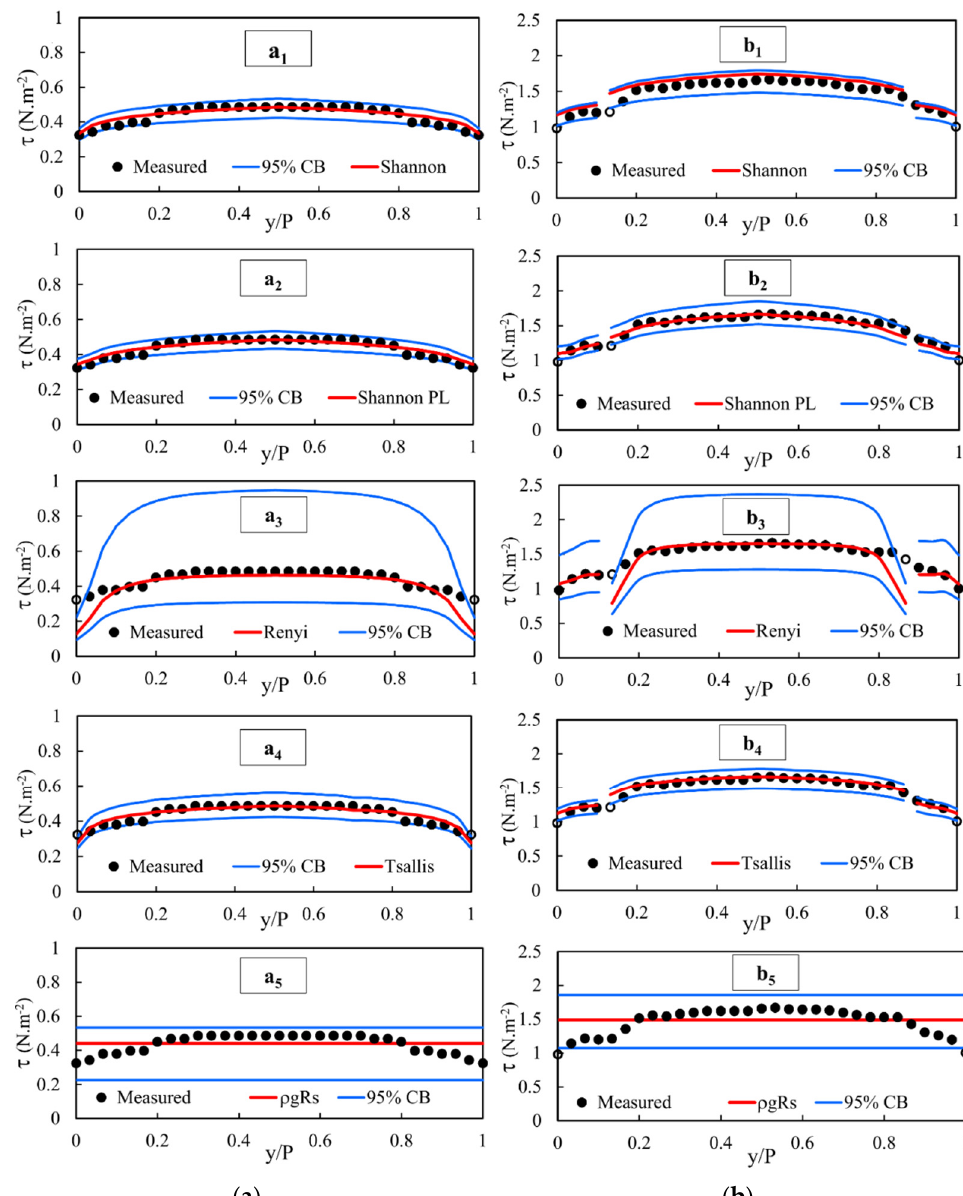
Figure 6. The 95% CB for uncertainty analyzing presented models in shear stress prediction by HBMES-1 method in ( a ) circular channel with height ratios t / D = 0, h + t/ D = 0.333; and ( b ) circular channel with flat bed with t / D = 0.25; h + t / D = 0.333).